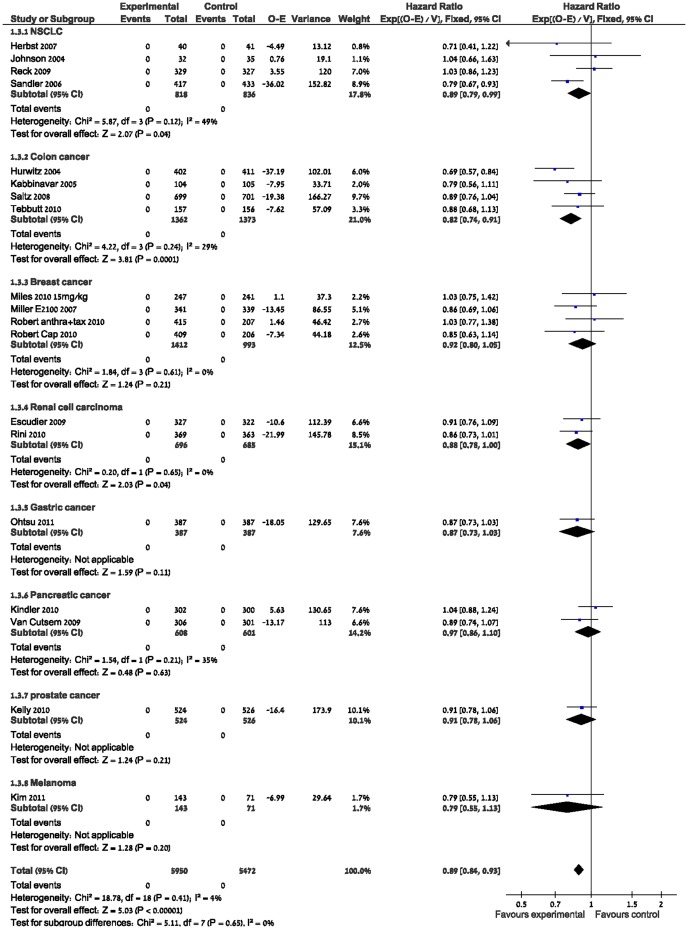
Overall survival.